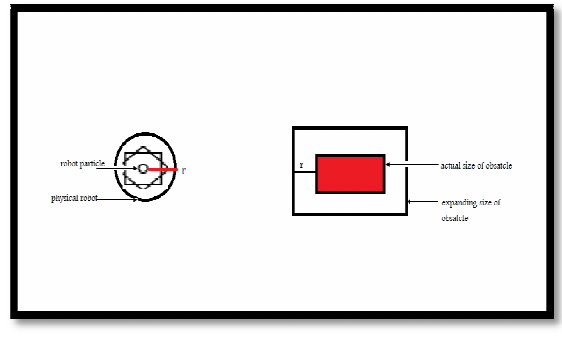
Fig. 4. Free space-based method. based method.